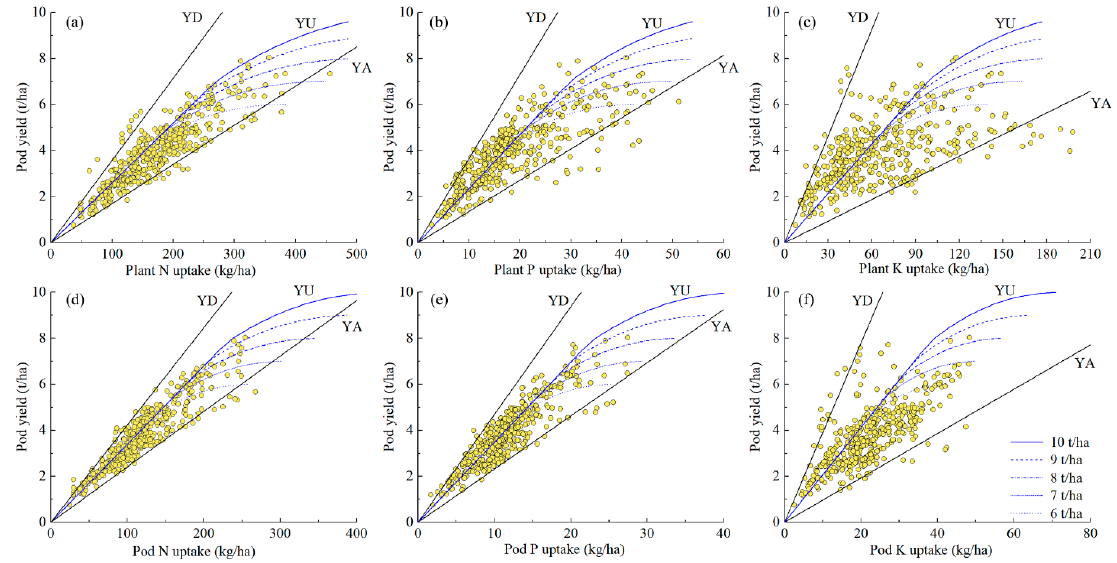
Figure 4. Relationships between pod yields and the N, P, and K accumulations in the total dry plant matter at maturity ( a – c ), and the N, P, and K removal in the pods ( d – f ) under different potential yields predicted by the quantitative evaluation of fertility of tropical soils (QUEFTS) model. In the figure, YD, YA, and YU represent the maximum dilution, maximum accumulation, and balanced uptake of the N, P, and K in the total dry plant matter or in the pod dry matter, respectively; These parameters were calculated by the QUEFTS model after excluding the upper and lower 2.5th percentiles of all the internal efficiency data (HI range: 0.4 to 0.82; and potential pod yield range: 6 to 10 t/ha. Table 4. Internal efficiency, balanced nutrient requirements of N, P, and K in total plants and pods, and removal ratios at different targeted pod yields simulated by the QUEFTS model for peanut crops in China with the potential yield set at 10 t/ha.